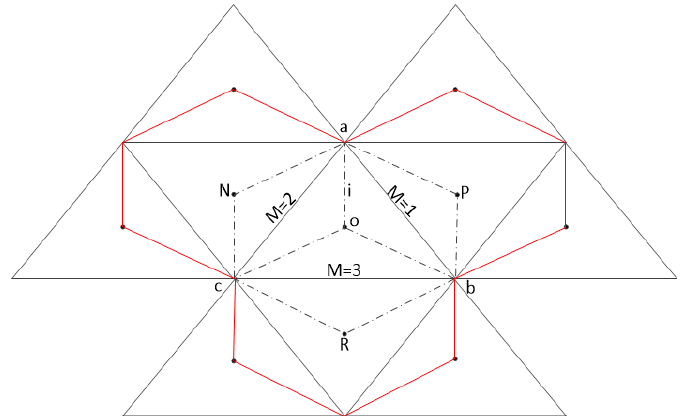
Figure 1. Control volume for flux calculation through cell interfaces.